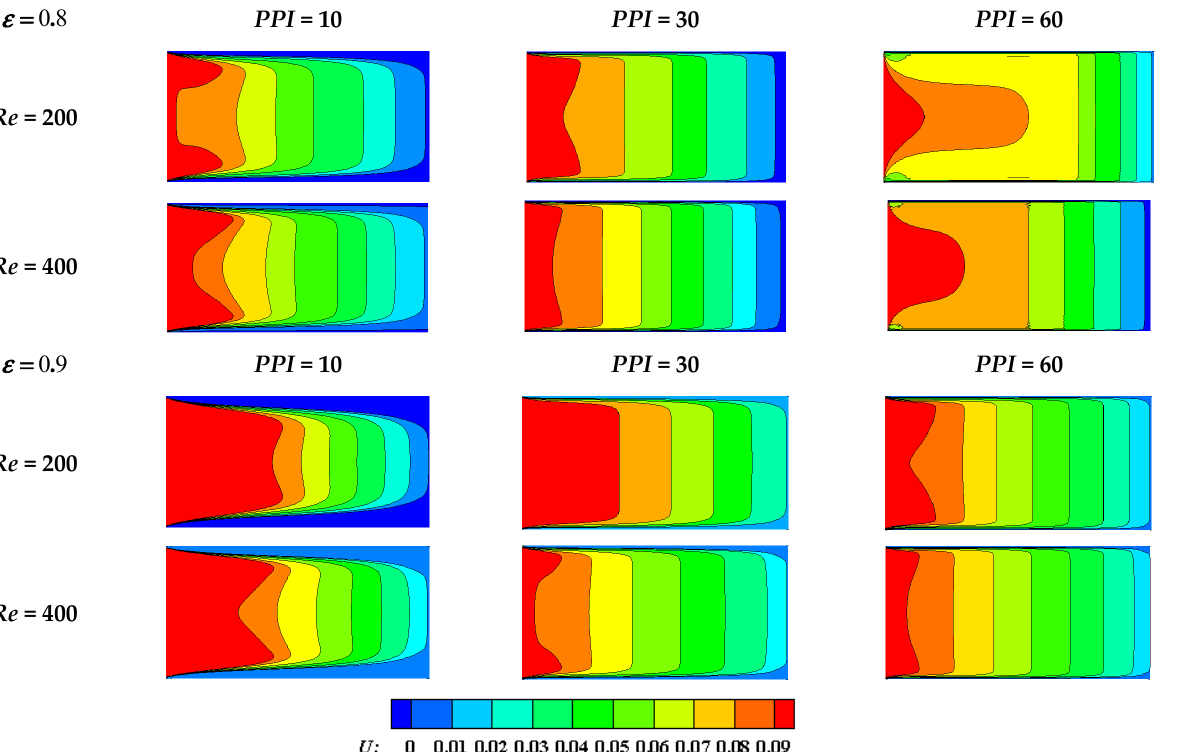
Figure 20 highlights the effect of pore density (PPI) on U -shaped contours during the charging process at the porosities 0.8 ε = and 0.9 , respectively. It can be observed that the PPI obviously influences the streamwise velocity ( U ) during charging and discharging Figure 19. Porosity effects on melt front ( Γ ) vs. time during charging process for Re = 400 with processes, even though the latter is deliberately left out here. 3 Pr = 50, Bi = 0.1, Ste = 1, Da = 10 − 3 , Kr = 1000, Rc = 1, Ec = 5 [118].